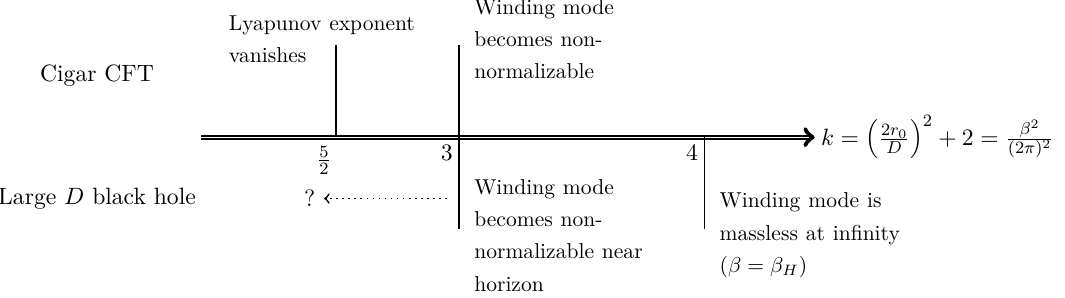
(cid:0) 2 r (cid:1) 2 + 2 where new 0 D